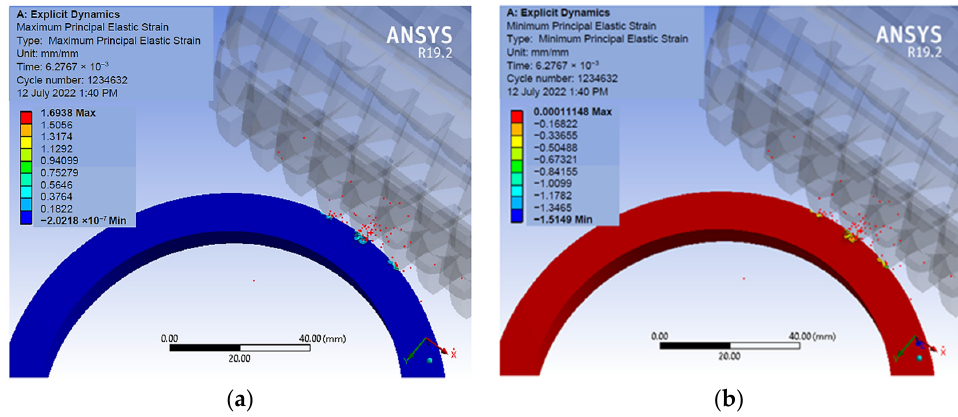
Figure 8. Computed ANSYS principal elastic strain map: ( a ) maximum; ( b ) minimum.